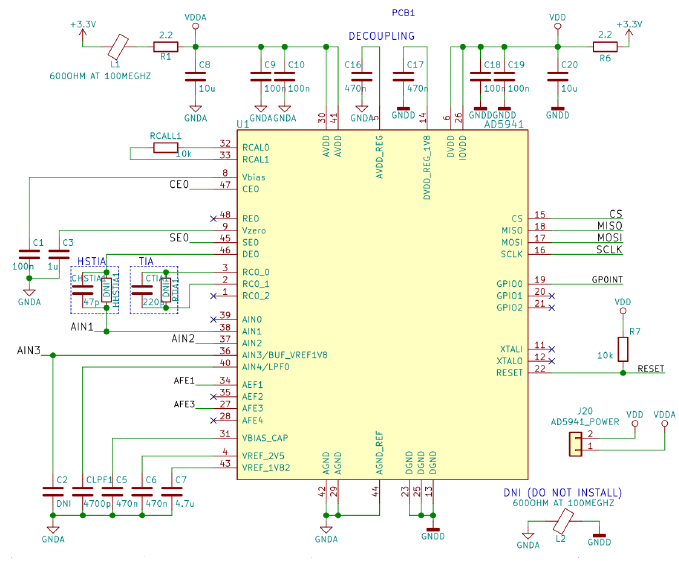
Figure 11. Circuit diagram for the EDA measurement unit, AD5941.